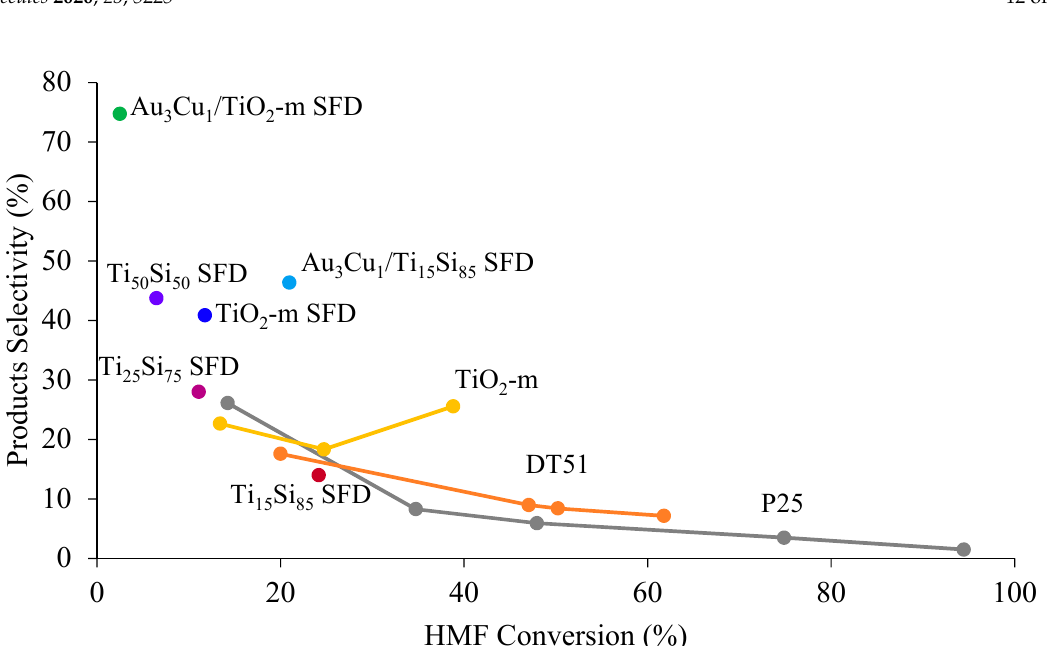
Figure 8. E ff ect of conversion on the total products selectivity of di ff erent titania-based photocatalysts.